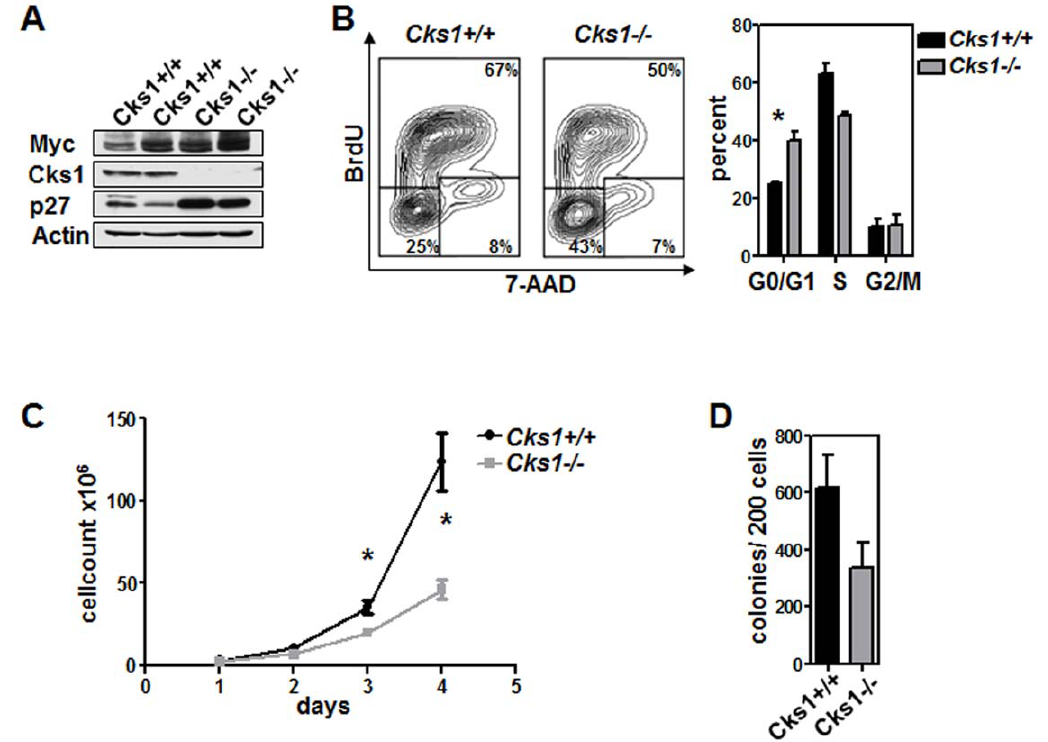
Figure 1. Cks1 -deficient E m - Myc lymphomas display reduced proliferation and colony formation in vitro. Primary Myc-induced lymphoma cells of the indicated Cks1 genotype were cultured in vitro until they were independent of stromal cell support. A , Immunoblot analysis of Myc, Cks1 and p27 Kip1 protein levels, representative analysis. B , Left panel: Representative flow cytometry dot plot images of in vitro BrdU-labelled lymphoma cells of the indicated Cks1 genotype. Right panel: the bars represent the mean 6 standard error of the mean of the indicated cell cycle phase. * indicates p , 0.05. C , Growth curve of in vitro cultured lymphoma cells of the indicated Cks1 genotype. Cells were replated daily and the growth curve calculated based on the -fold increase in cell number starting with 1 6 10 6 cells (day 1). The graph represents the mean 6 standard deviation from 3 independent experiments. * indicates p , 0.05. D , 200 E m - Myc lymphoma cells of the indicated Cks1 genotype were plated in methylcellulose. The number of colonies was counted on day 7. The graph represents the mean 6 standard deviation from 2 independent experiments.